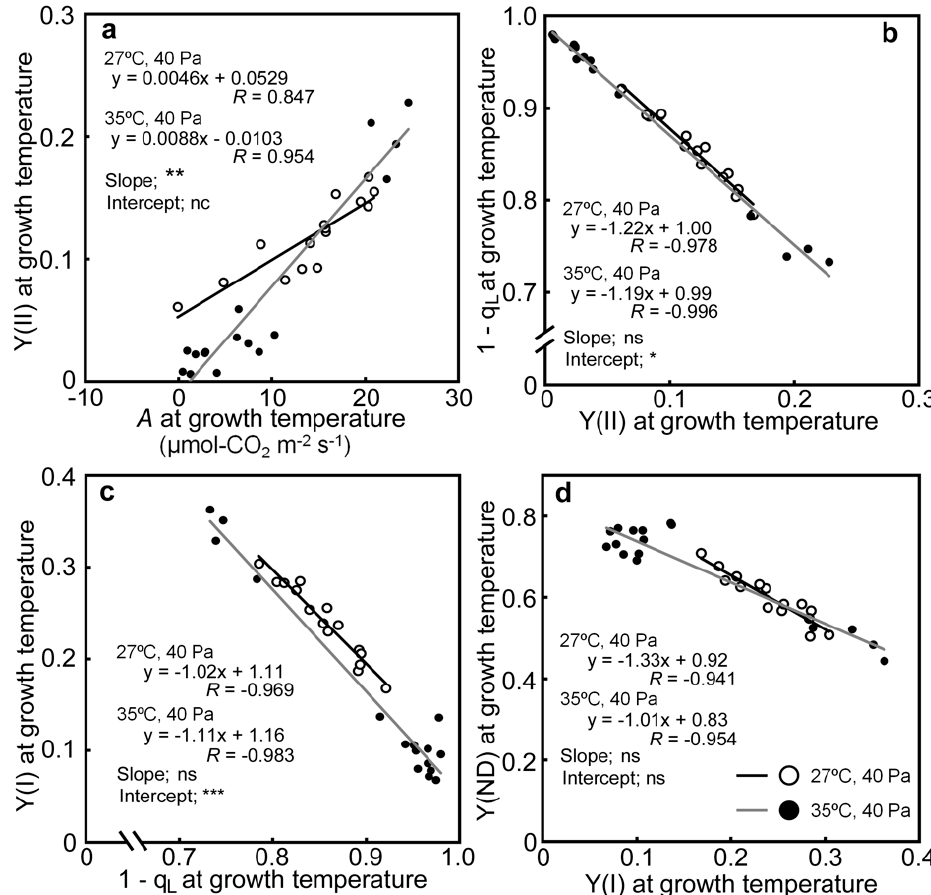
Figure 6. Relationship between Y(II) and A ( a ), 1 − q L and Y(I) and Y(II) ( b ), Y(I) and 1 − q L ( c ), and Y(ND) and Y(I) ( d ). The data are taken from Figures 2, 4, and 5. Regression lines were made from a dataset, obtained at a given air temperature. White and black circles correspond to data obtained from drought-stressed plants at 27/22°C and 35/30°C, respectively. The results of statistical treatments between regression lines by ANCOVA were presented in each panel. The slopes of regression lines were tested first. When there were no significant differences, the intercepts of the regression lines were tested. *, **, and *** denote statistically significant differences at p < 0.05, 0.01, and 0.001, respectively. The ns and nc notations denote not significant and not calculated, respectively.